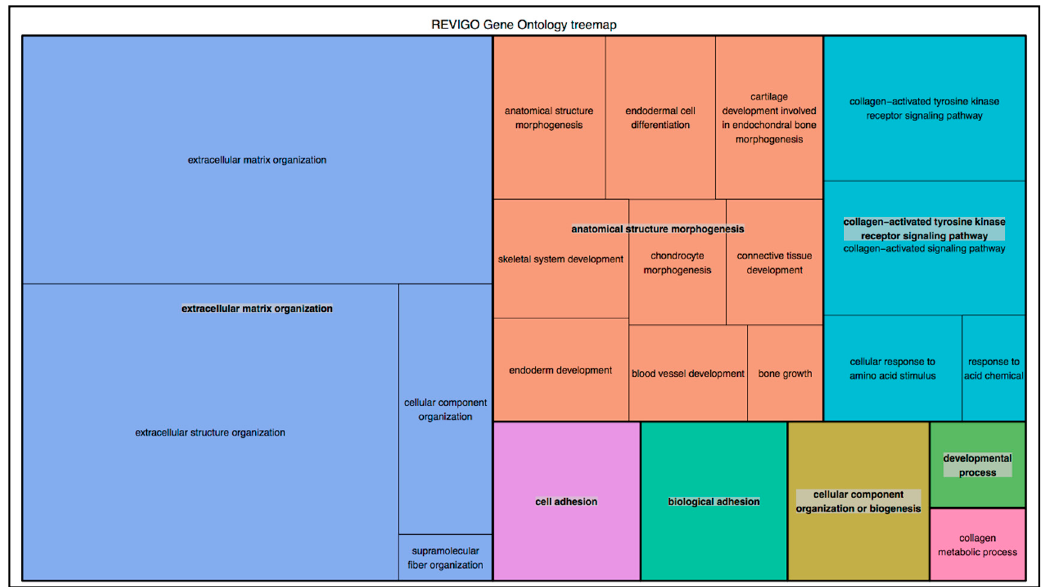
Figure 2. Tree-map of pathways clustered by semantic similarity from the set of collagen Differentially Expressed Genes (DEGs) . The plot shows three super-clusters, namely Extracellular Matrix Organization, Anatomical Structure Morphogenesis, Collagen-activated Tyrosine Kinase Receptor Signaling Pathway and several clusters, such as Cell Adhesion and Collagen Metabolic Process. The prioritization of the three genes of interest followed the interpretation of this functional analysis. The size of the rectangles reflects the absolute log 10 p. These data have been extracted from the RNA-seq dataset published by Tsoi et al. 2019 [16].